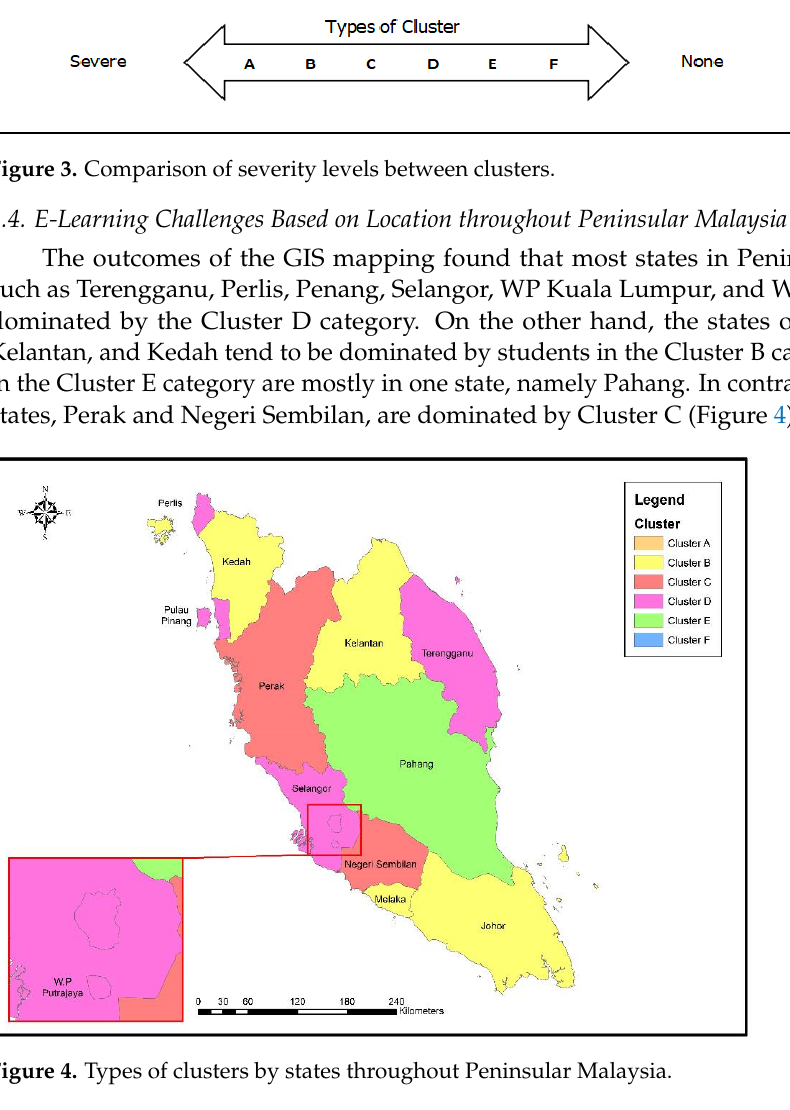
Table 5. Kruskal-Wallis test results for e-learning, hybrid, and face-to-face learning methods. Domain